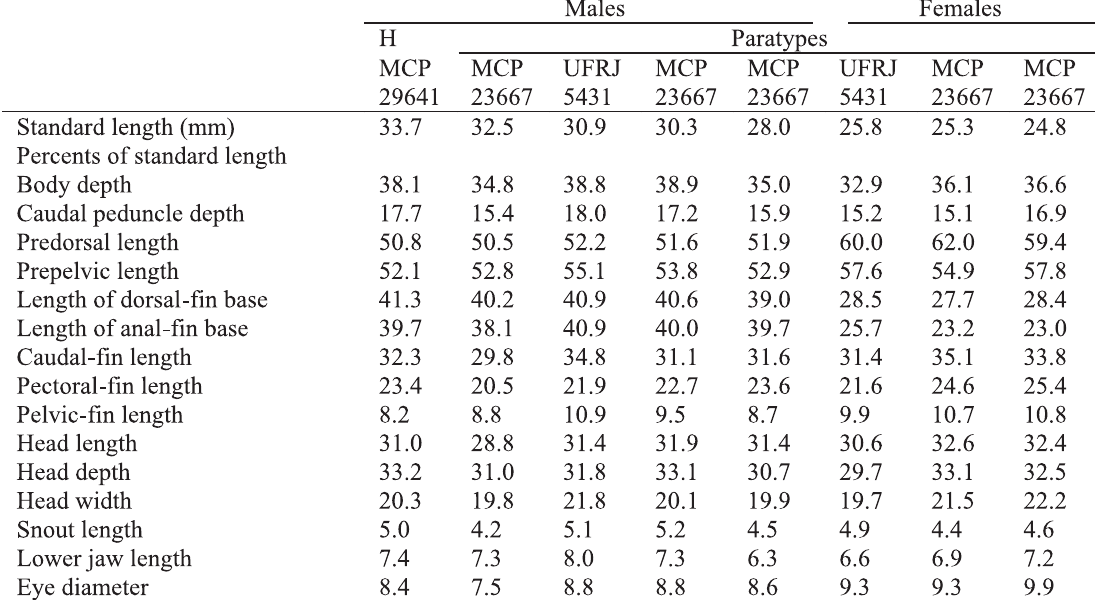
Table 1. Morphometric data of holotype (H) and seven paratypes of Austrolebias varzeae